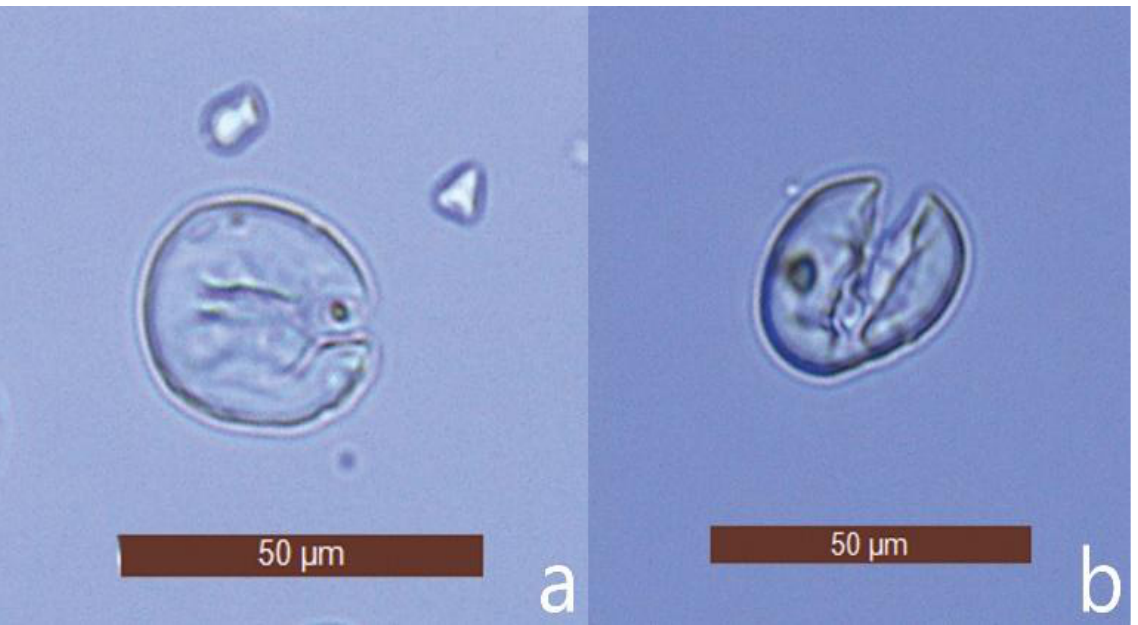
Figure 8. Experimental einkorn (a) and barley (b) starch granules showing cracks induced by grinding (ERC